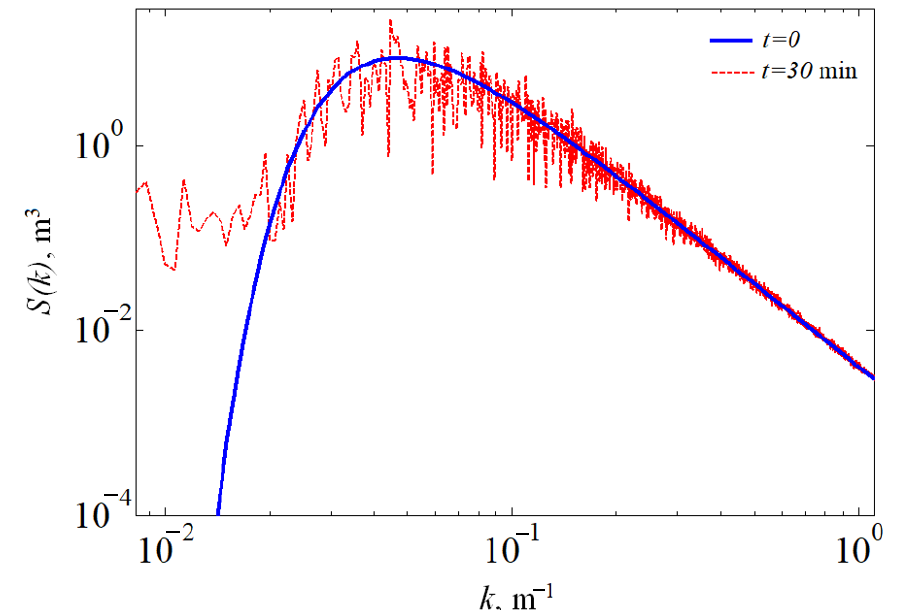
Figure 7. The wave spectrum transformation.